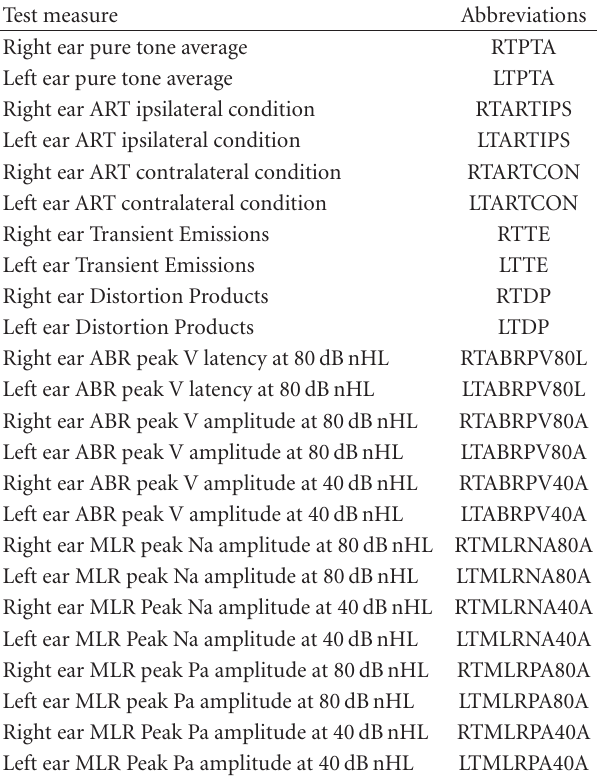
Table 1: The 24 test measures selected as possible predictors from the audiological test battery (left column) and their abbreviations (right column). Note. Pure tone average was obtained by averaging hearing thresholds at 500, 1000, and 2000